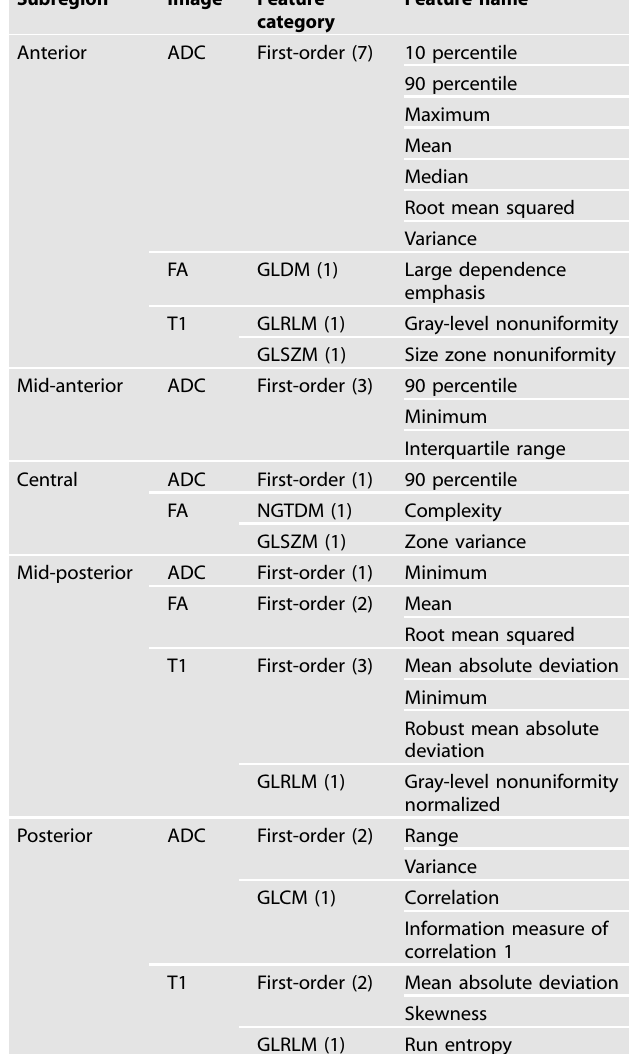
Table 2. List of signi fi cant radiomic features to differentiate participants with schizophrenia from